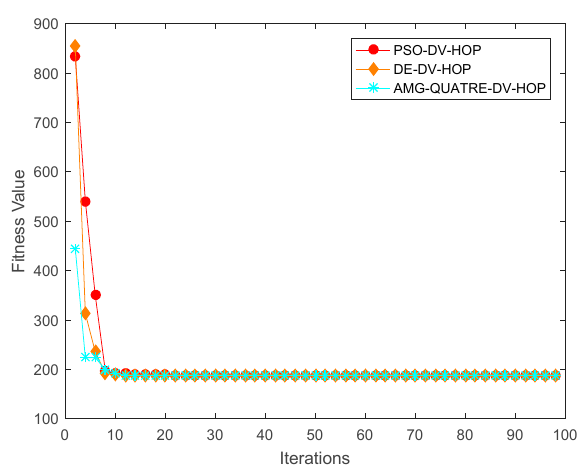
Figure 12. Comparison of convergence curve of the applied AMG-QUATRE with PSO and DE methods for single simulation (Number of the sensor node 400, Number of anchor node 40, Communication range 20).